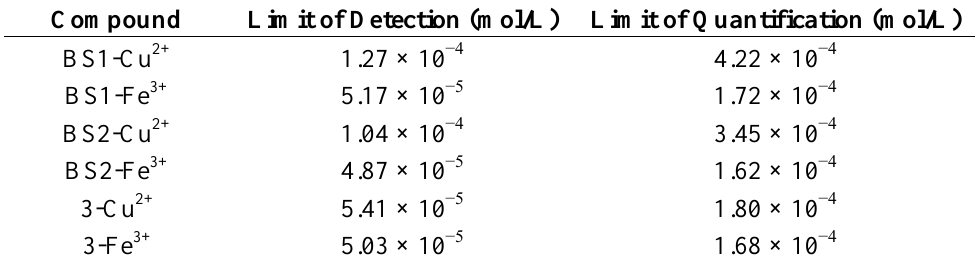
Table 2. Detection and quantification limit for each tested